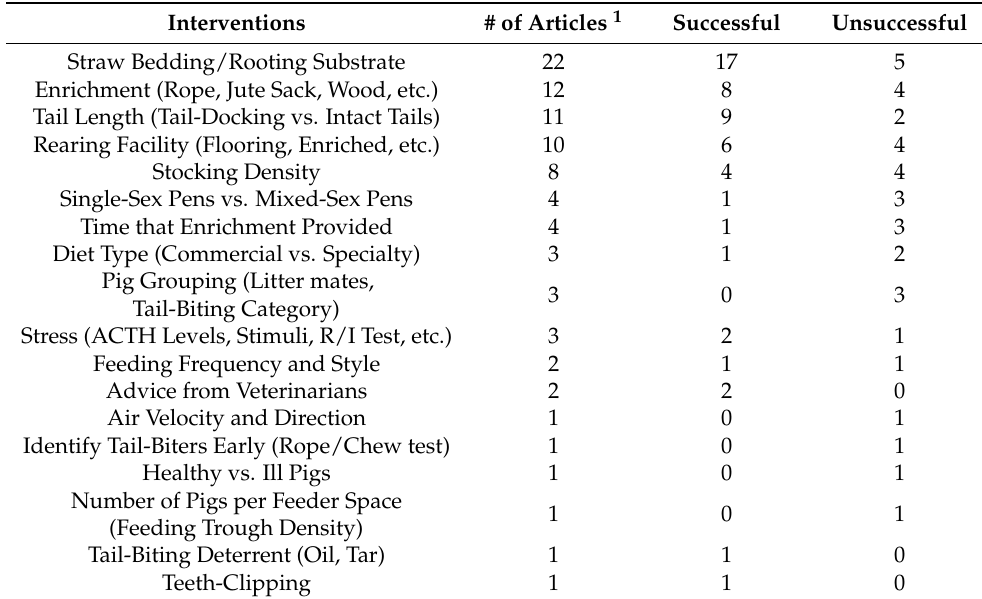
Important for TB Outcome